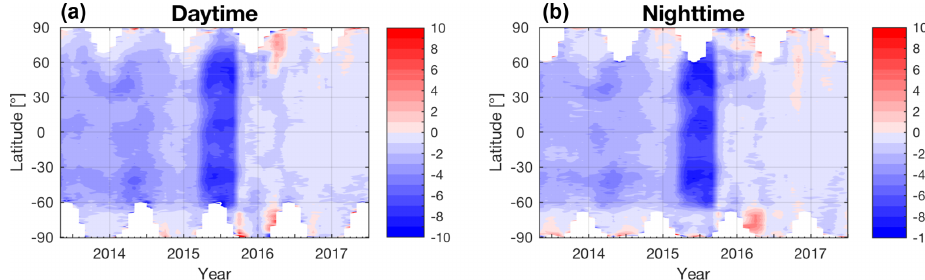
Figure 4. Same as Fig. 3 but for the TROPO O 3 column products (defined as the column integrated between the surface and